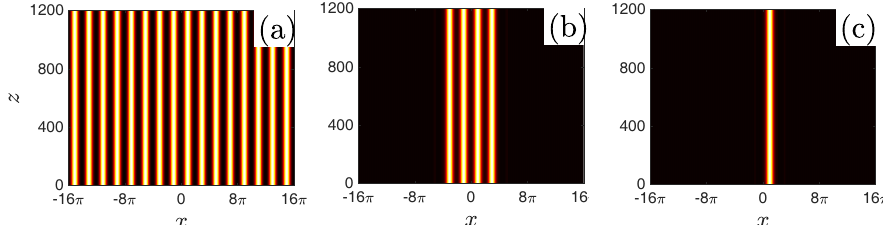
Figure 7. Numerical propagation simulation of NLBW ( a ), truncated-Bloch-wave soliton ( b ) and FGS ( c ) shown in Figure